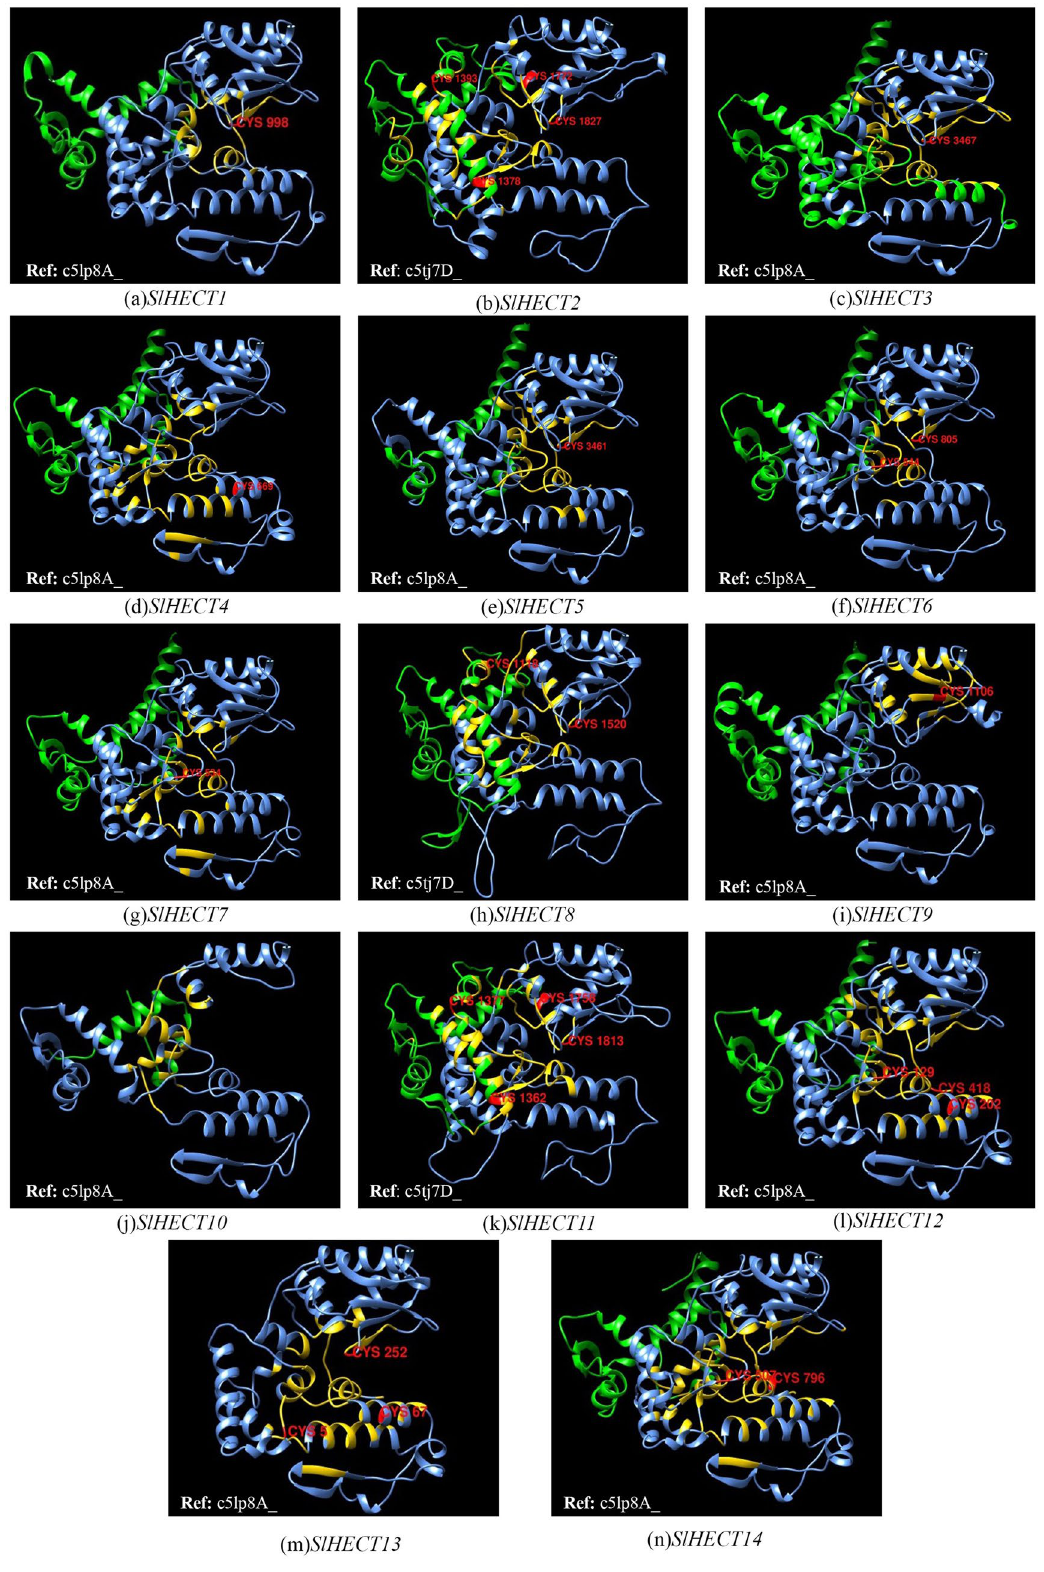
Figure 5. Three-dimensional structures of fourteen HECT E3 ubiquitin ligase proteins of S. lycopersicum ( a – n ) . The HECT domain, cysteine residues, binding pockets, and remaining residues, are highlighted with blue, red, golden, and green colors, respectively. The corresponding reference templates used for each model are highlighted in all the